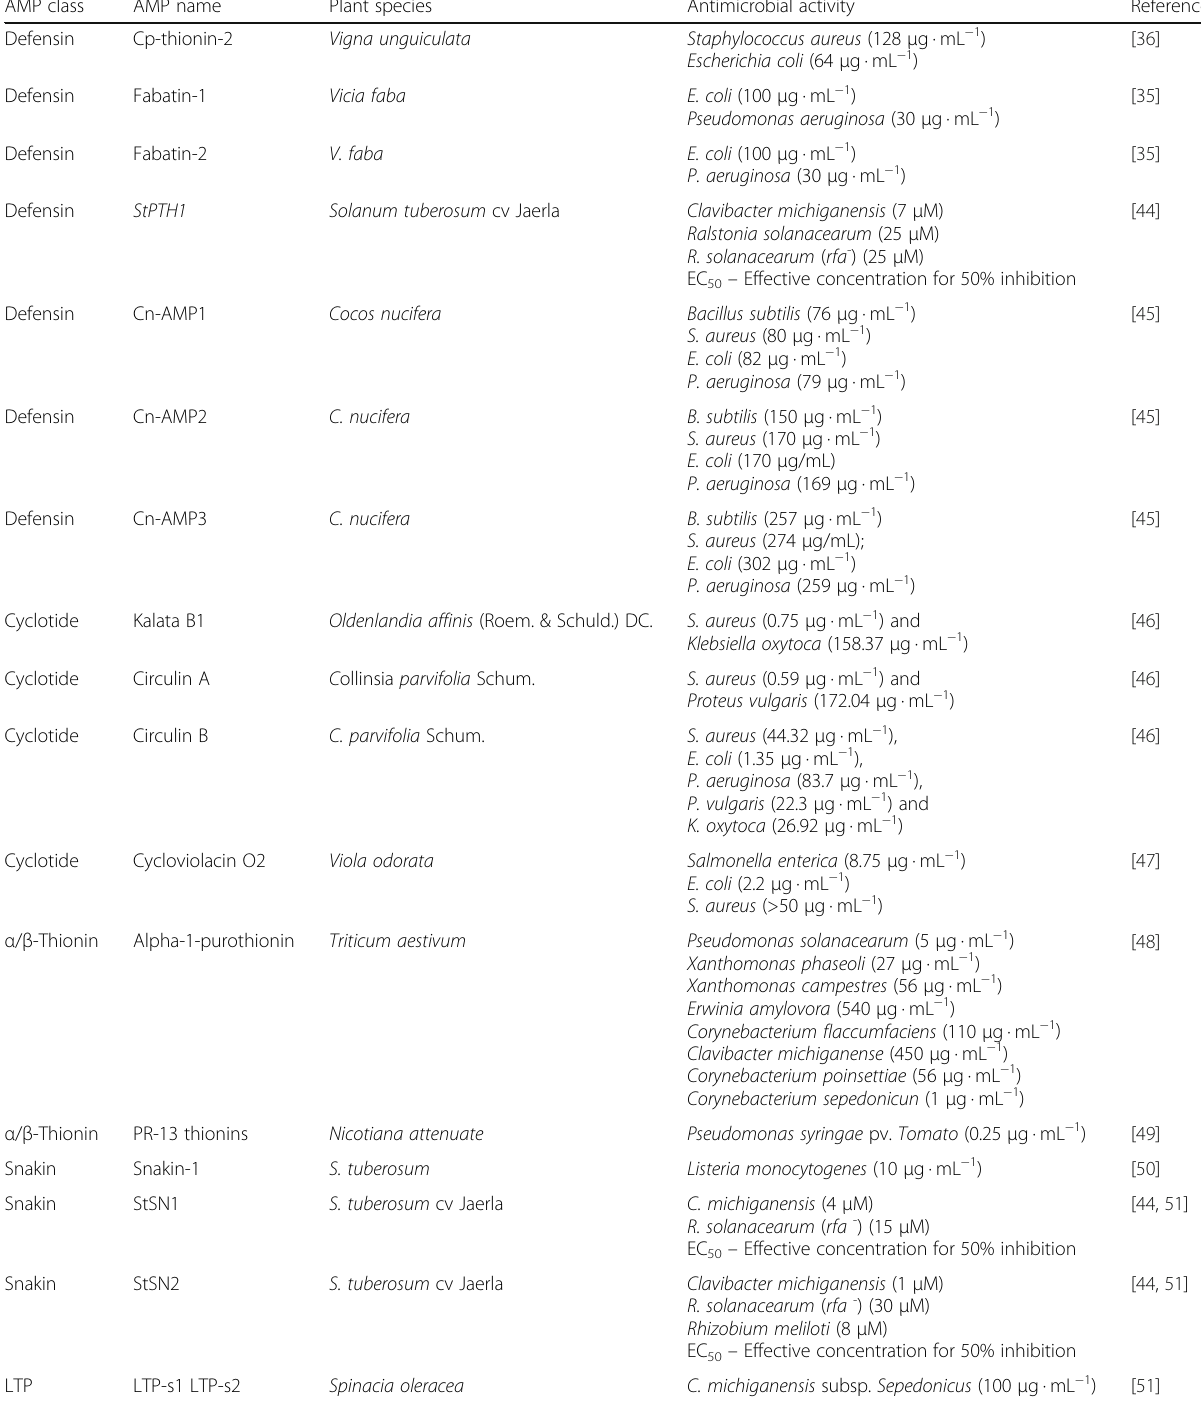
Table 1 Antimicrobial activity of some peptide classes AMP